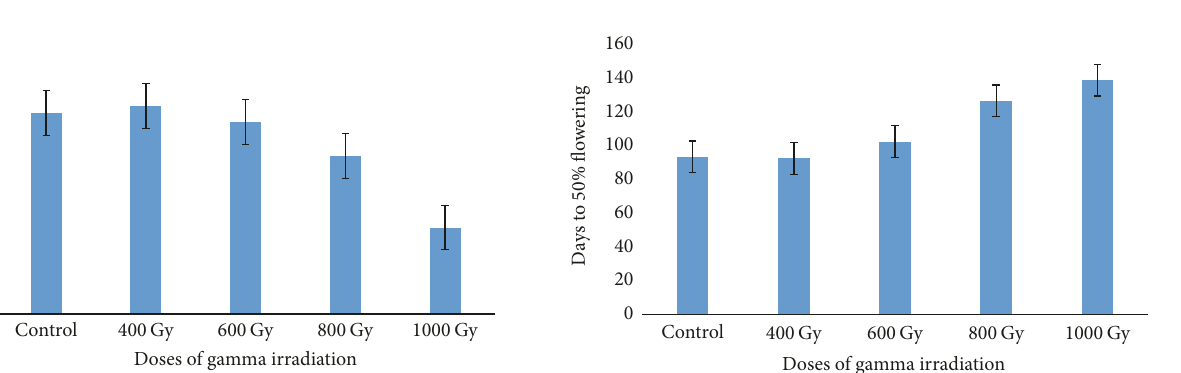
Figure 7: Effect of gamma irradiation on number of days to 50% flowering in